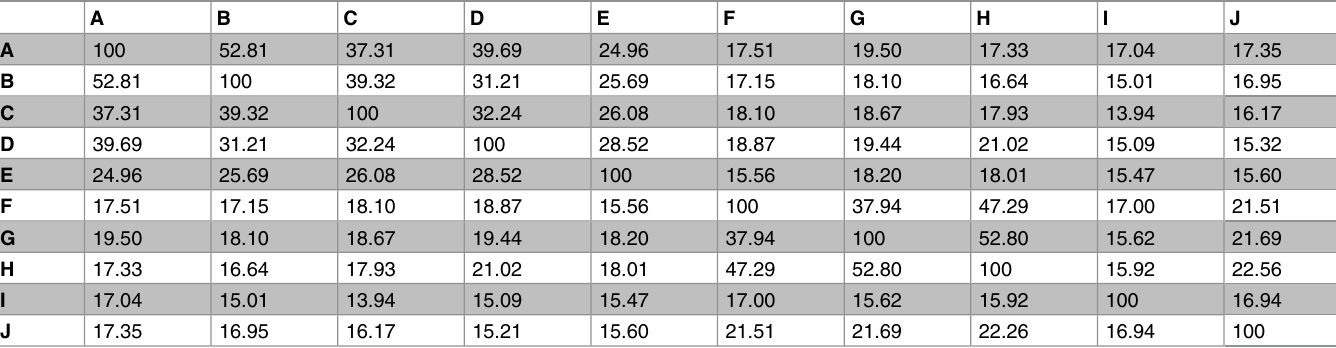
Table 3. The percent of identity among 6-Cys protein family